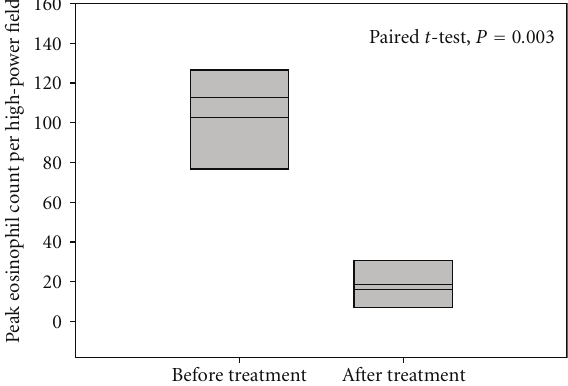
Figure 3: Changes in the mucosal mean peak eosinophil count following treatment in EE ( n =